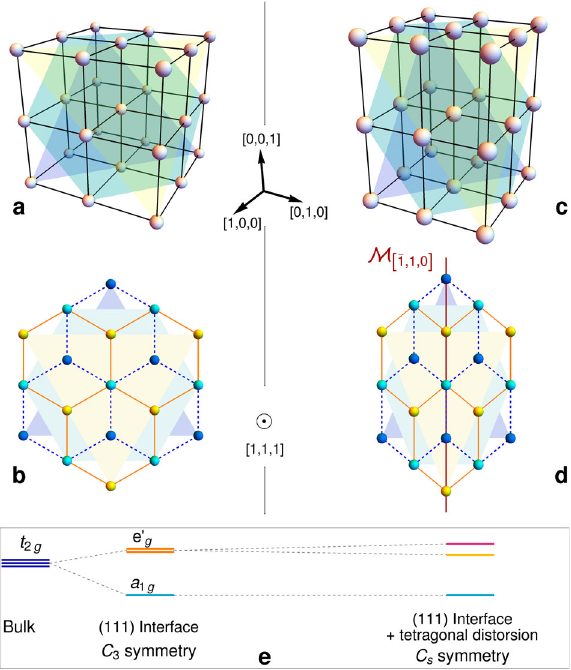
Fig. 2 Materials, crystal symmetries and orbital splittings. a Schematic representation of an ABO 3 pervoskite cubic unit cell displaying the three interlaced transition metal [111] planes. b Corresponding top view along the [111] crystallographic direction. We only show the B transition metal atoms. c , d show the effect of a tetragonal distortion with the [001] direction being the tetragonal axis. The distortion breaks the threefold rotation symmetry around the [111] axis but leaves a residual mirror symmetry. e Evolution of the orbital states at the Γ point of the BZ with quenched angular